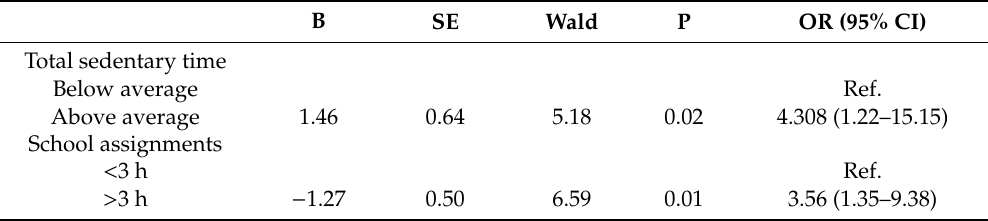
Table 4. Binary logistic regression for depression by total sedentary behavior and school assignments of sedentary among design students. B SE